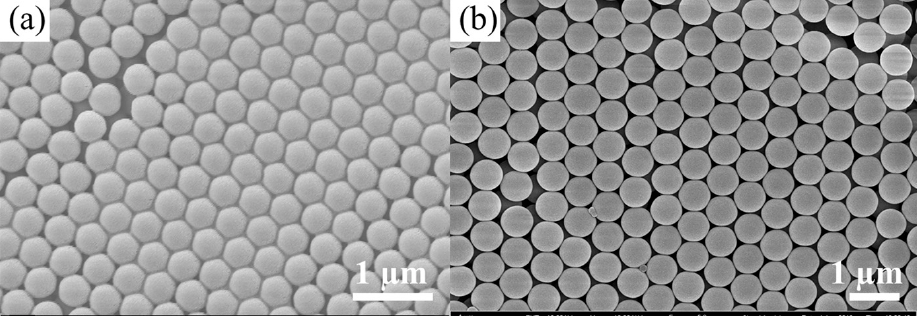
Figure 4. SEM images of synthesized SMs with particle sizes of ( a ) 451 nm and ( b ) 547 nm.